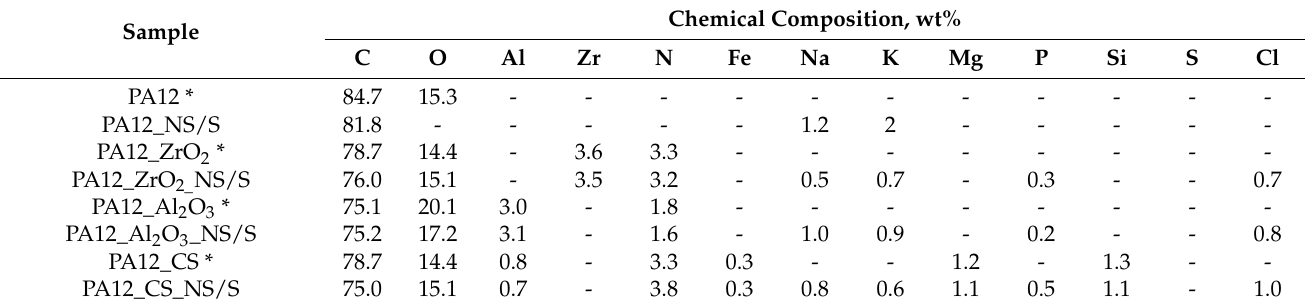
Table 9. Comparison of the chemical composition from EDS investigations: samples before and after artificial ageing.